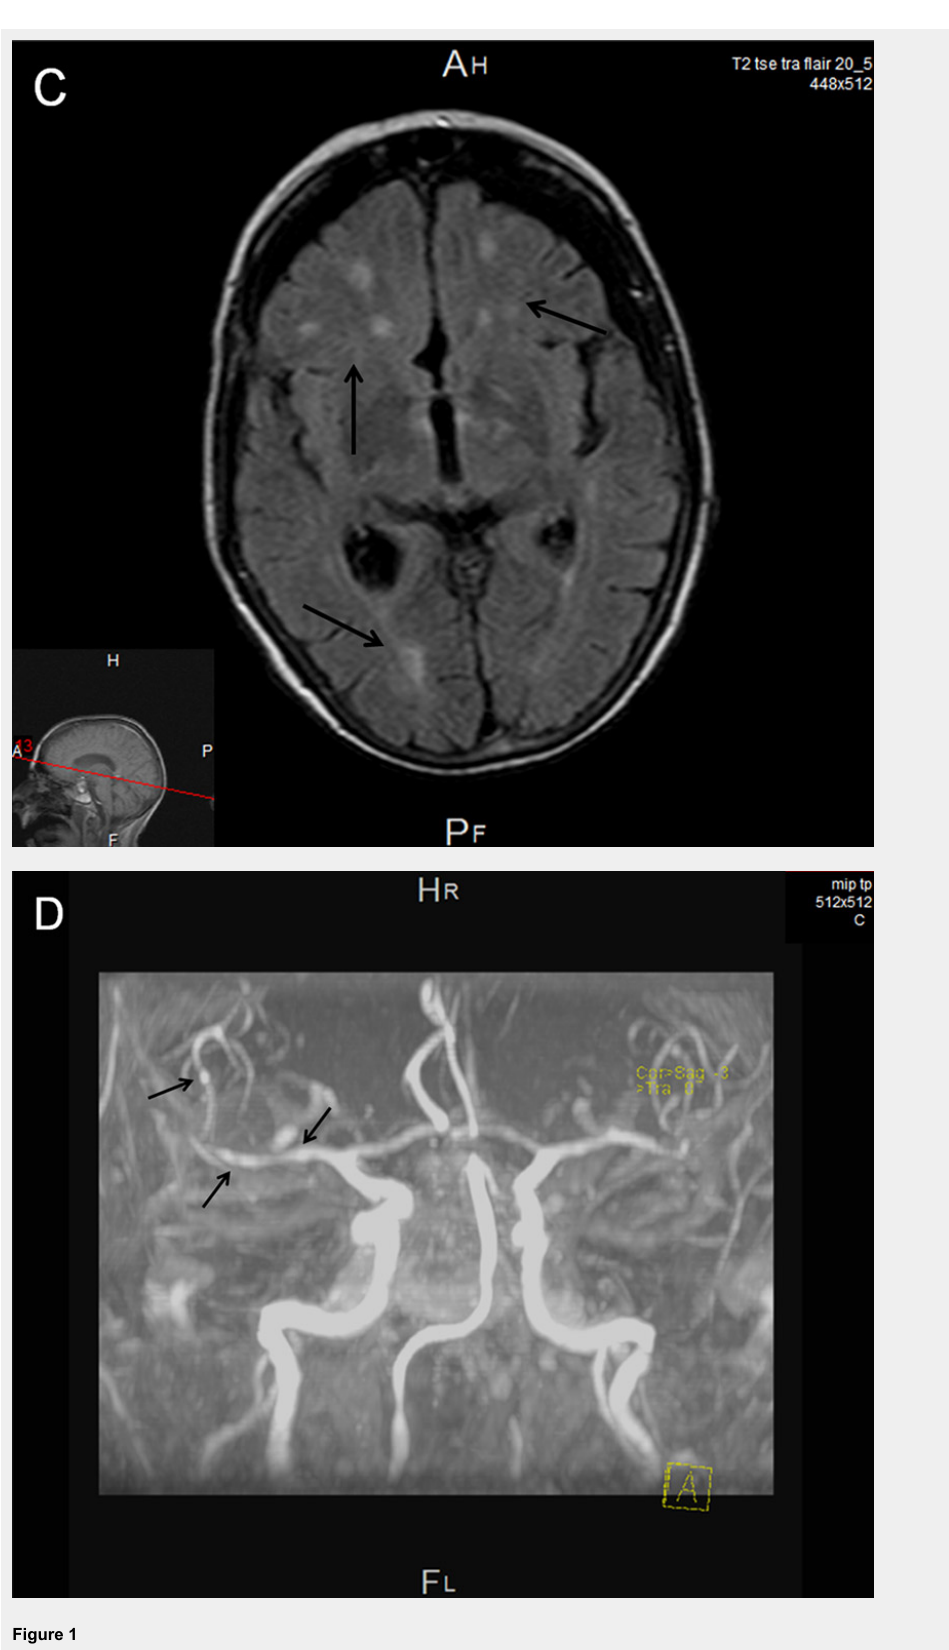
Cerebral MRI. A, B Axial diffusion-weighted images: Areas of ischaemic necrosis in the pons (A), and thalami and basal ganglia bilaterally (B). C Axial FLAIR image: Areas of ischaemia in the subcortical anterior and posterior territories. D MR angiography: Arrows highlight arterial irregularities suggestive of